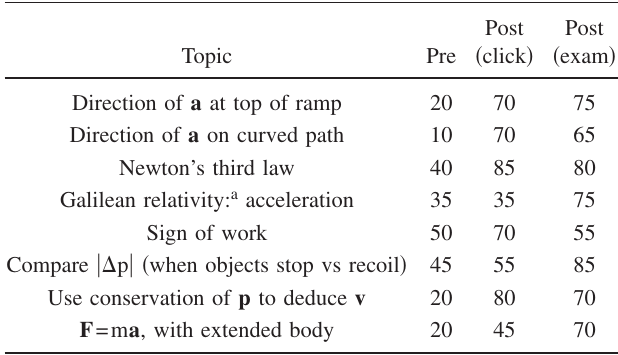
TABLE I. Averaged scores (cid:1) percent correct (cid:2) on selected concep- tual topics targeted by tutorials, rounded to the nearest 5%.